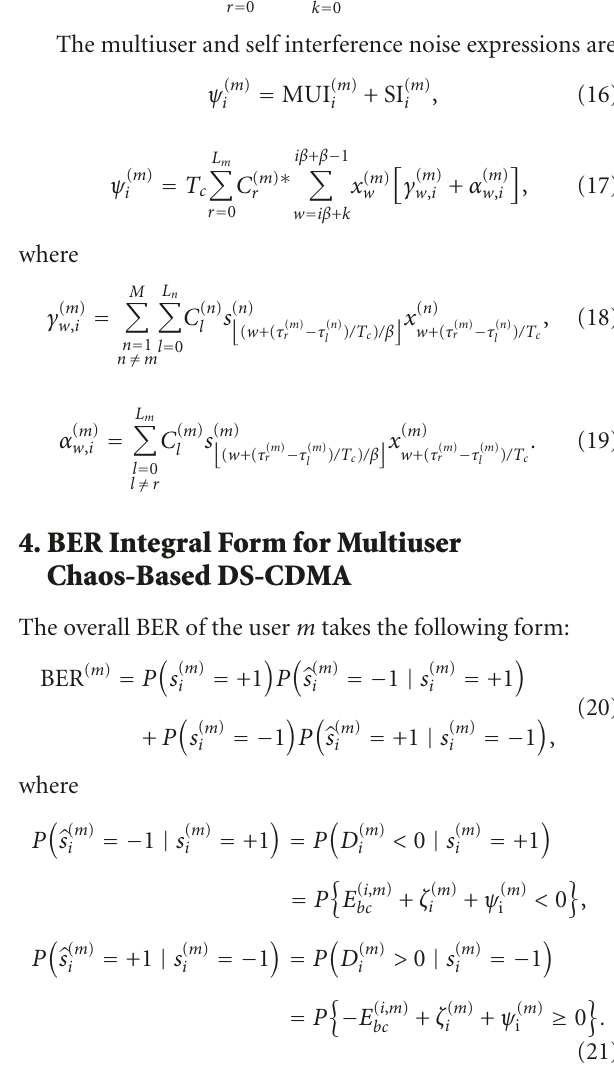
Figure 2: Probability density functions of bit energy for PWL chaotic sequence ( β =